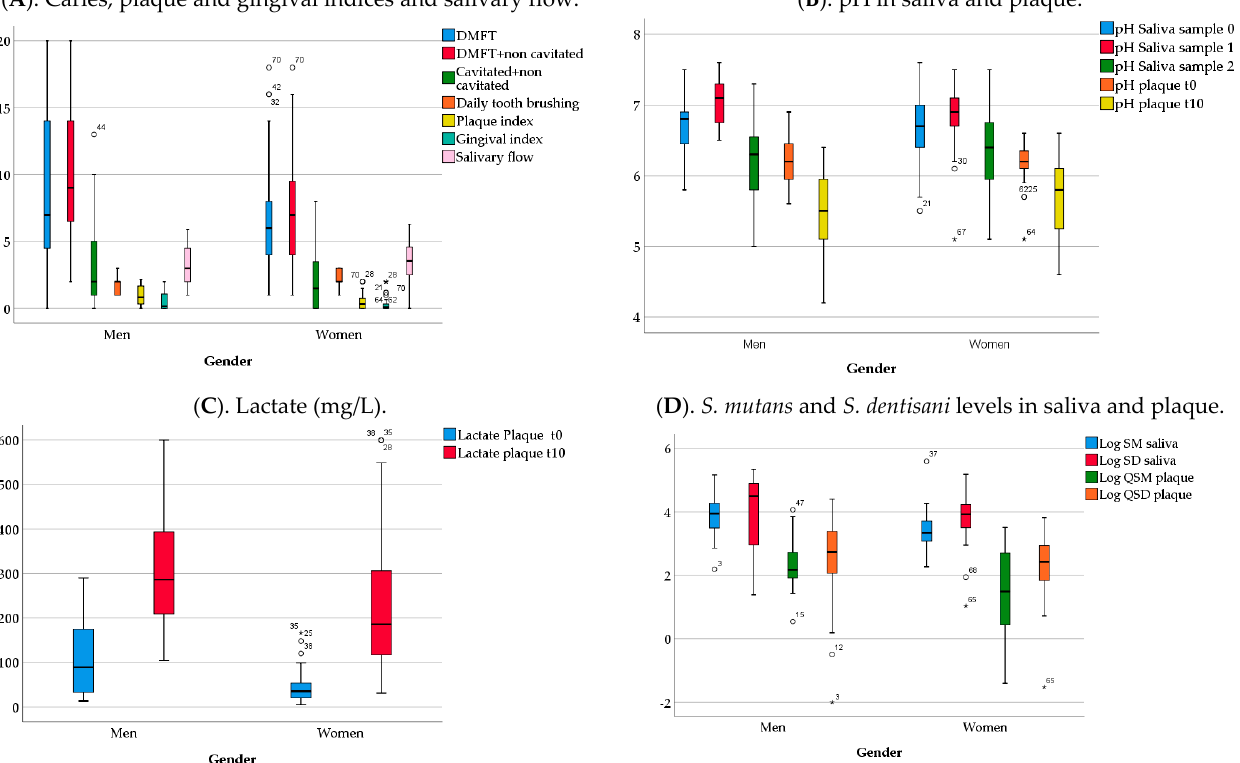
Figure 1. Clinical, biochemical and microbiological variables by gender. The graphs show medians and IQR values for the different variables. ( A ) DMFT = ICDAS codes 3–6 + restoration ICDAS codes 7 and 8 + missing teeth due to caries + filled teeth due to caries. DMFT with non-cavitated lesions = DMFT + ICDAS codes 1–6 + restoration ICDAS codes 7 and 8. ( B ) pH_saliva (sample 0) = basal salivary pH. pH_saliva (sample 1) = salivary pH after tooth-brushing. pH_saliva (sample 2) = salivary pH after sugar rinse. pH plaque t0 = plaque pH before sugar rinse. pH plaque t10 = plaque pH after sugar rinse. ( C ) Lactate plaque t0 = plaque lactate levels before sugar rinse (mg/L). Lactate plaque t10 = plaque lactate levels after sugar rinse (mg/L). ( D ) Log SM saliva = Log10 transformation of normalized CFUs/mL of S. mutans in saliva, Log SD saliva = Log10 transformation of normalized CFUs/mL of S. dentisani in saliva. Log QSM plaque = Log10 transformation of normalized CFUs/ng of S. mutans in plaque, Log QSD plaque = Log10 transformation of normalized CFUs/ng of S. dentisani in plaque. The expected loss in statistical power due to the difference in male:female ratio is